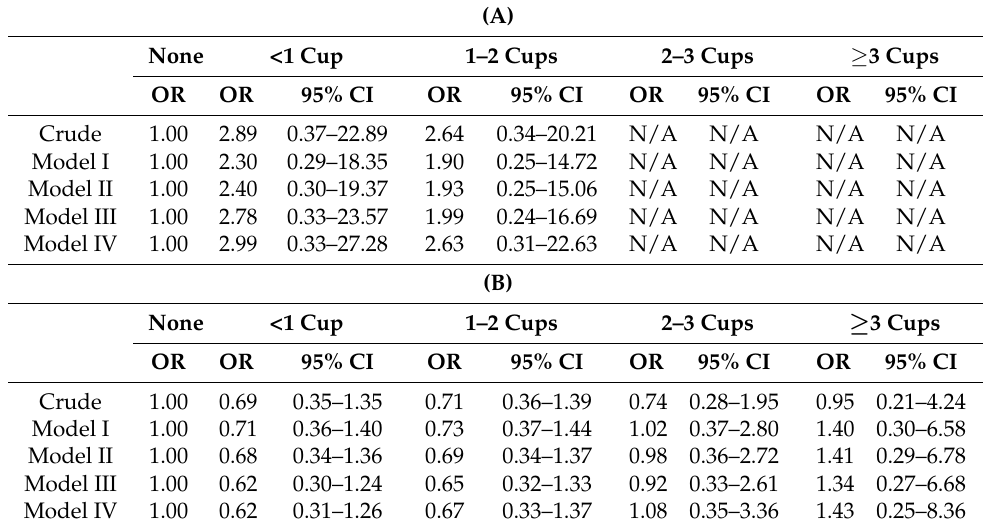
Table 3. ORs and 95% CIs for RA by coffee consumption in men (A) and women